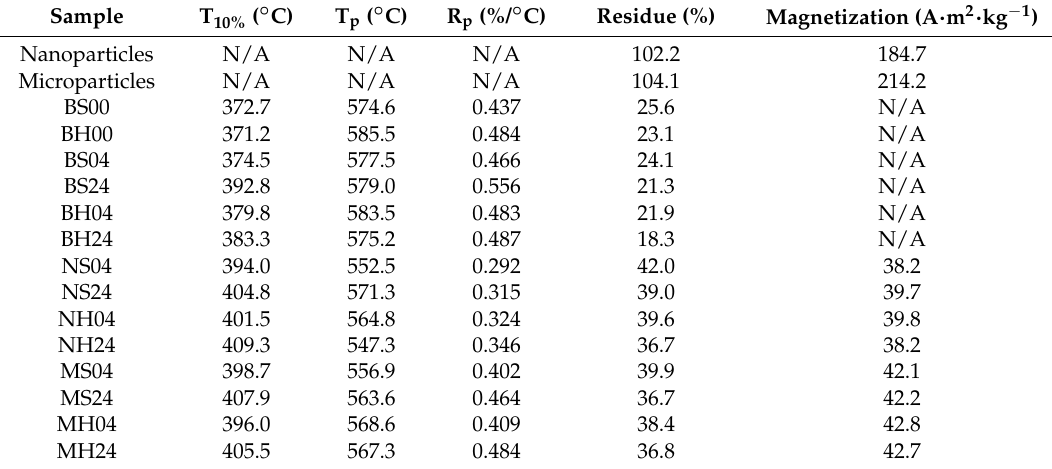
Figure 8. ( a ) Vibrating sample magnetometer VSM data of iron magnetic nano- and microparticle powders; ( b ) hard matrix MRE samples reinforced with nano- and microparticles. Table 4. Measured material samples’ TGA and derivative of the thermogravimetric curve (DTG), and the saturation magnetization of MRE (measured by VSM) parameter values.